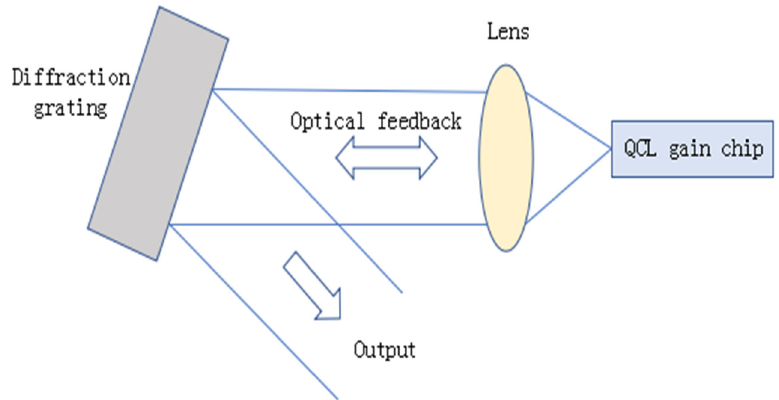
Figure 3. Littrow structure of